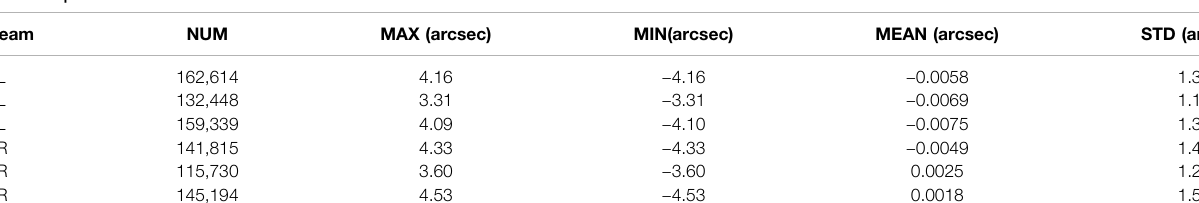
TABLE 4 | Statistical information of IS-2 ATVD. Beam